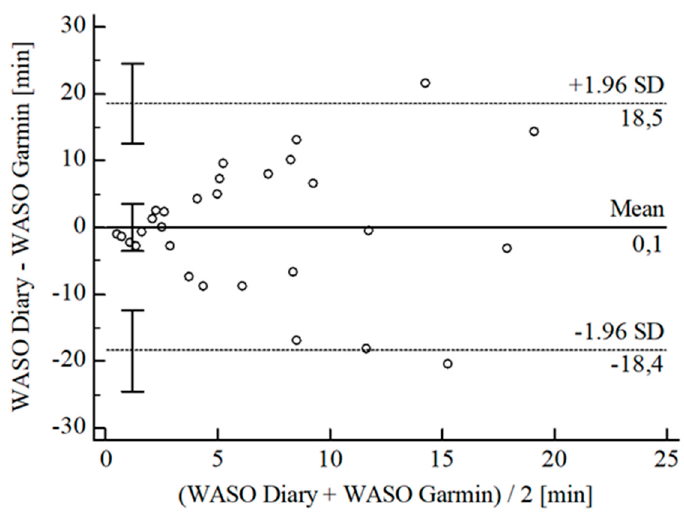
Figure 13. Bland-Altman Plot for WASO Garmin ® vs. diary.